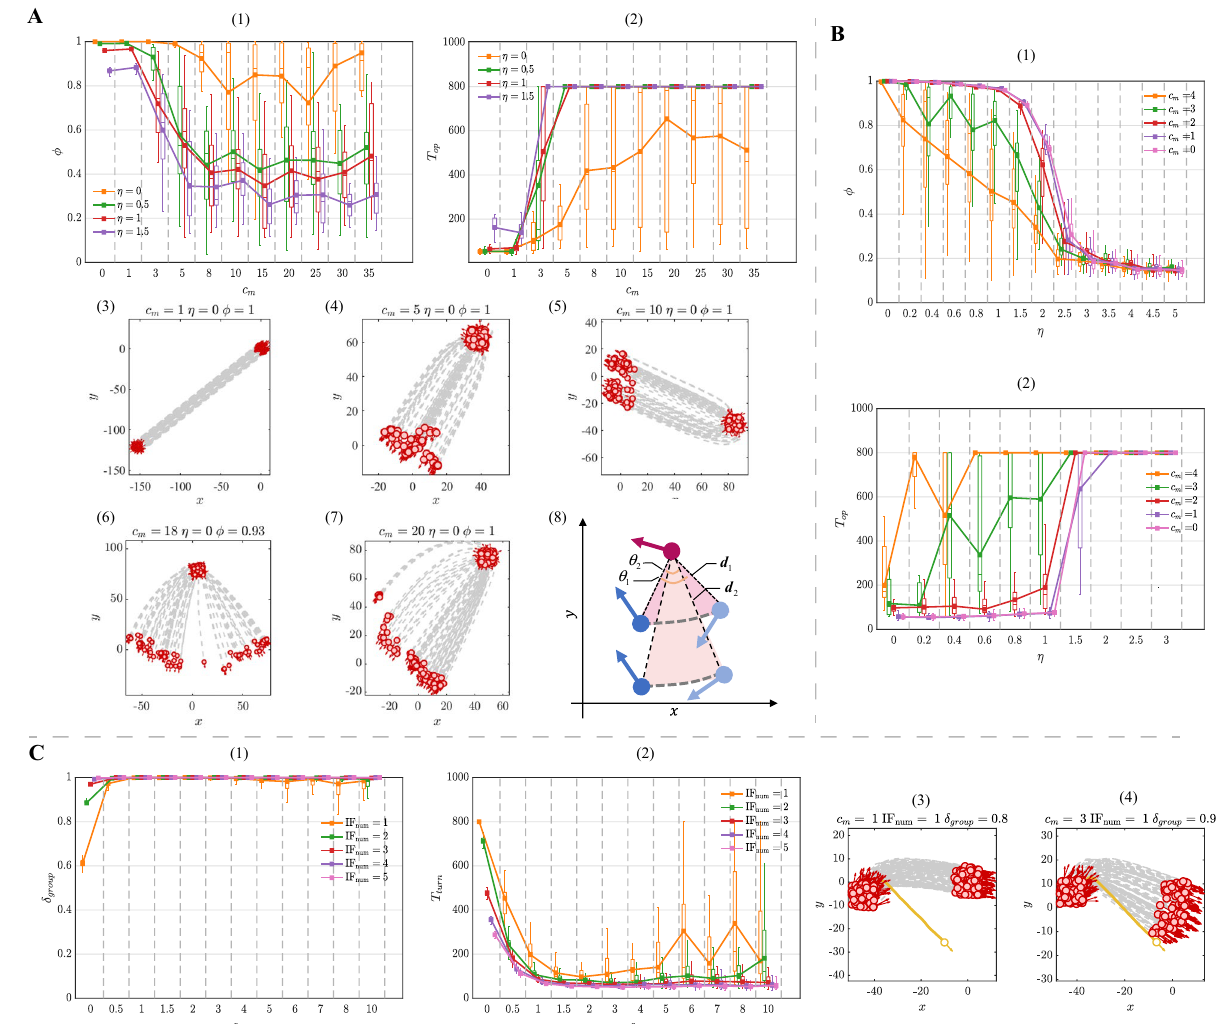
Figure 6. ( A ) The property of flocking as the evolution of c m in the DYB-S model. ( A -(1)) The polarization φ as a function of c m . ( A -(2)) The convergence time T op as a function of c m . ( A -(3–6)) The trajectories of flocking with different c m . ( A -(3–7)) The illustration of bearing change of neighbor with different distance. When the distance d 1 < d 2 , it is evident to find that θ 1 > θ 2 if the traveling distance is the same. ( B ) The property of flocking as the evolution of η in the DYB-S model. ( B -(1)) The polarization φ as a function of noise η . ( B - (2)) The convergence time T op as a function of noise η . ( C ) The property of responsivity to stimulus with the evolution of c m in the DYB-S model. ( C -(1)) The response accuracy δ group as a function of c m . ( C -(2)) The response time T turn as a function of c m . ( C -(3–4)) The trajectories of response to stimulus with different c m . T op = 800 or T turn = 800 indicate that the group is unable to finish the corresponding case within the total simulation time. Each data point represents the average of 50 simulation runs with the boxplot. Boxplots in the block divided by the dotted line belong to the same data point but are shifted at different positions on the x-axis to be more